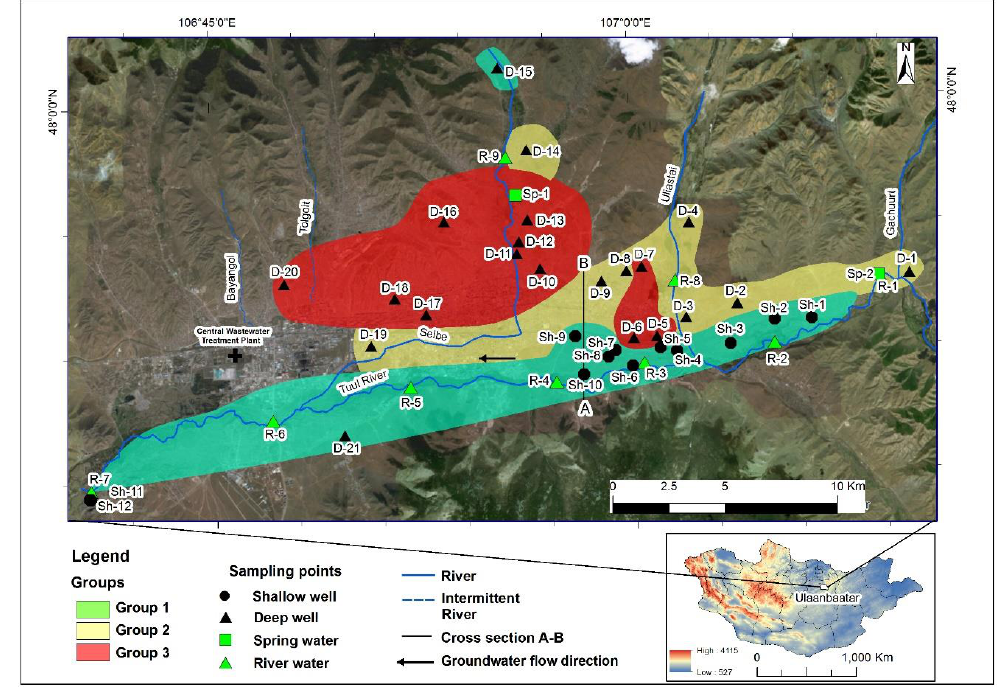
Figure 6. Spatial distribution of the groundwater well groups with different hydrochemical characteristics in the study area.